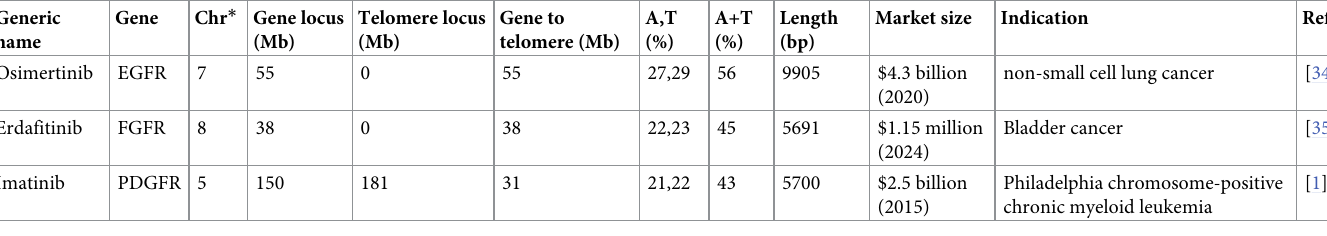
Table 1. Two factor characteristics of protein kinases targeted by the FDA-approved